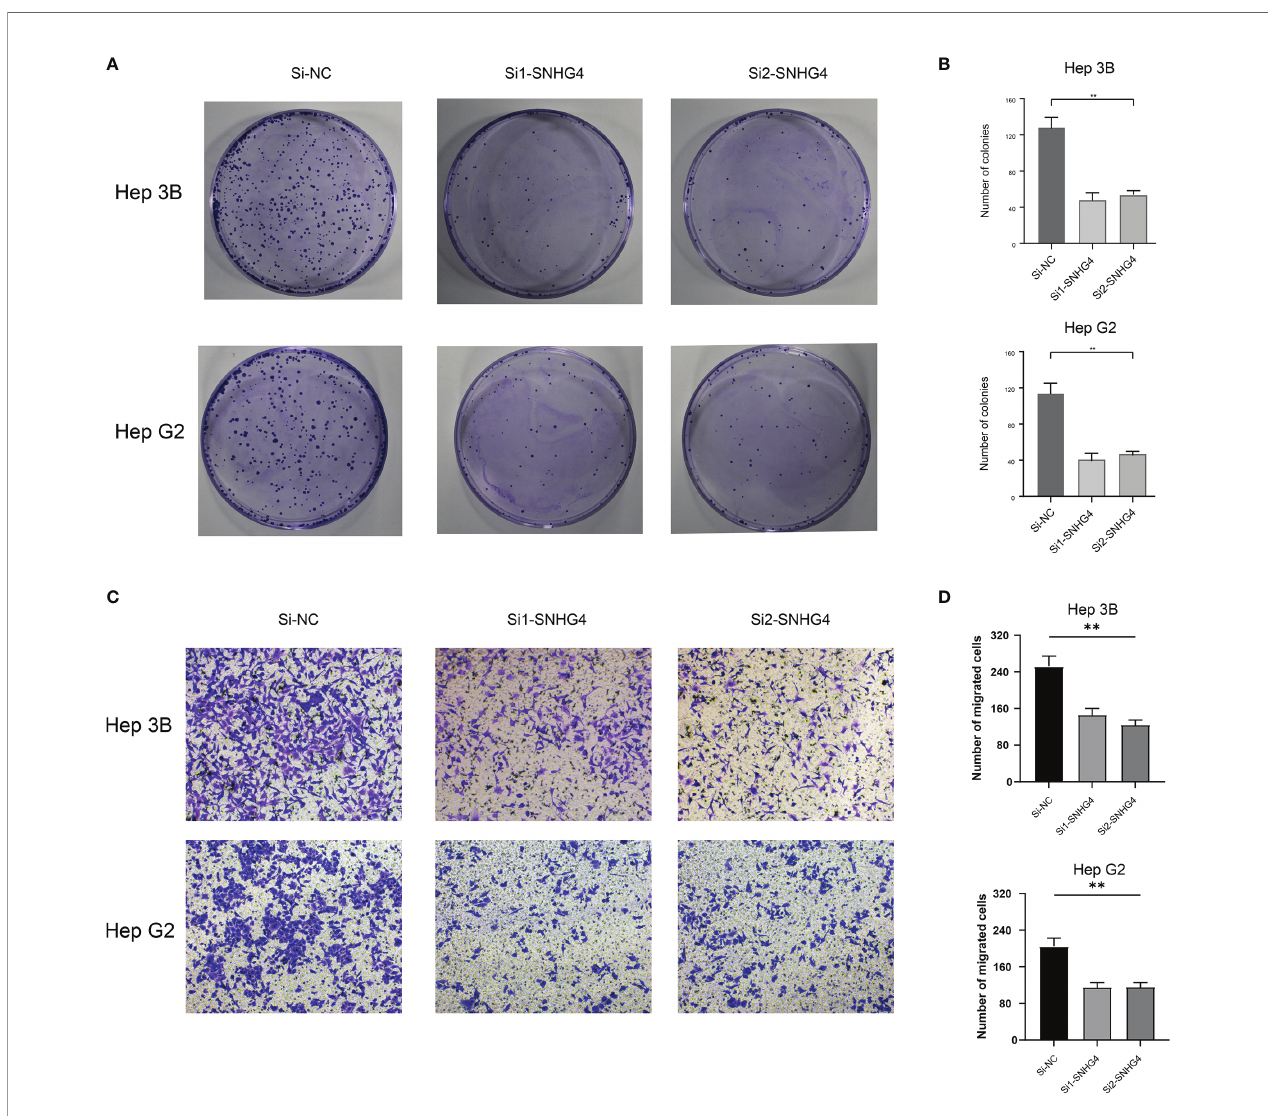
FIGURE 8 | (A, B) Clone formation assay. (C, D) Transwell assay. * represents p < 0.05; ** represents p < 0.01; *** represents p <